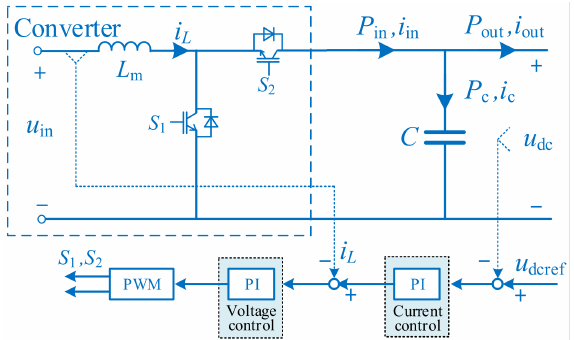
Figure 2. Power relationship of dc-link capacitor